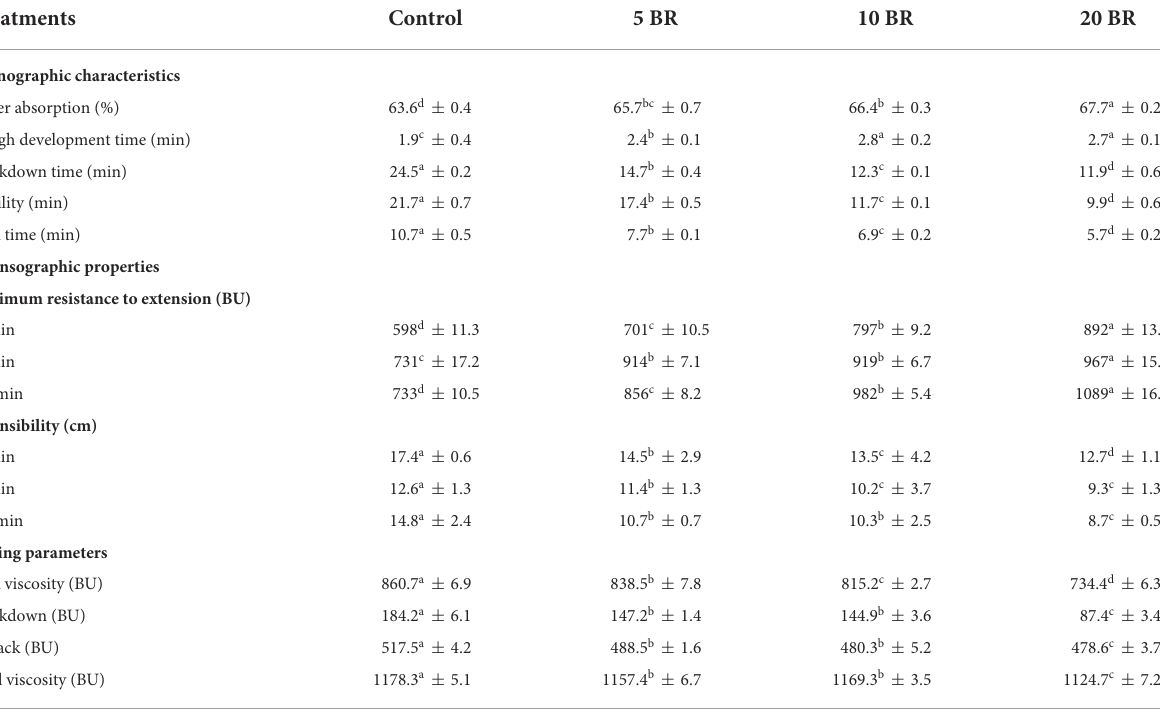
TABLE 1 Rheological characteristics and pasting properties of wheat dough with different proportions of black rice flour.